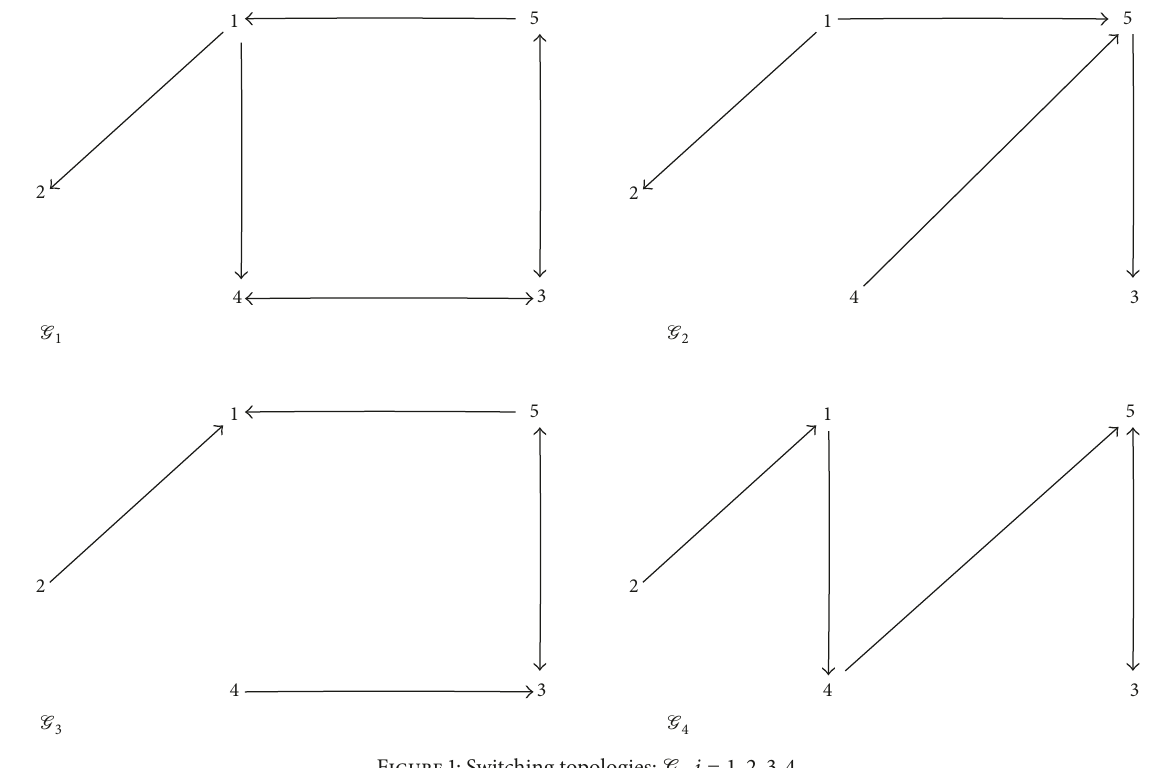
Figure 1: Switching topologies: G 𝑖 , 𝑖 = 1, 2,3, 4 .